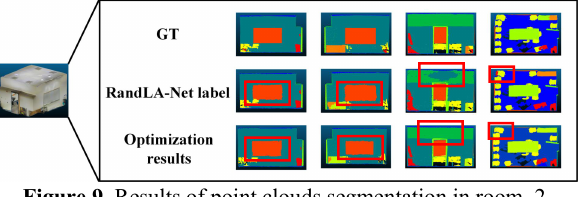
Figure 9. Results of point clouds segmentation in room_2.